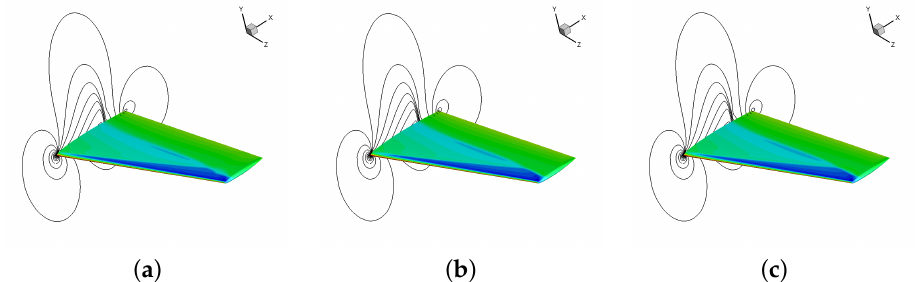
Figure 21. Comparison of the surface pressure coefficient calculated by three models. ( a ) SA-NN.